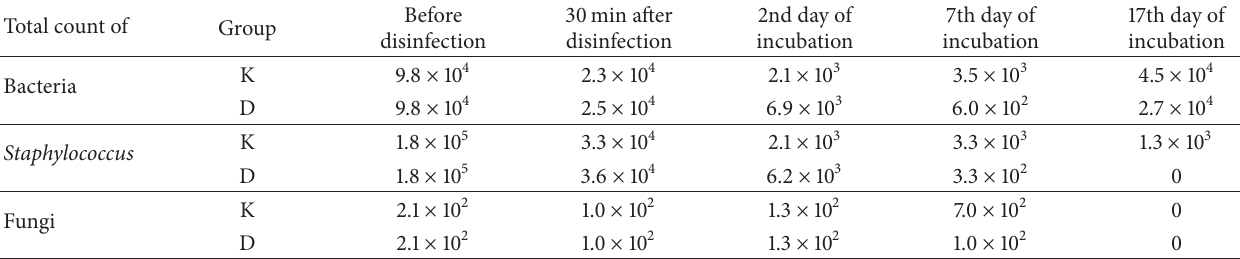
Table 9: Microbiological contamination of eggs during incubation [cfu/egg].